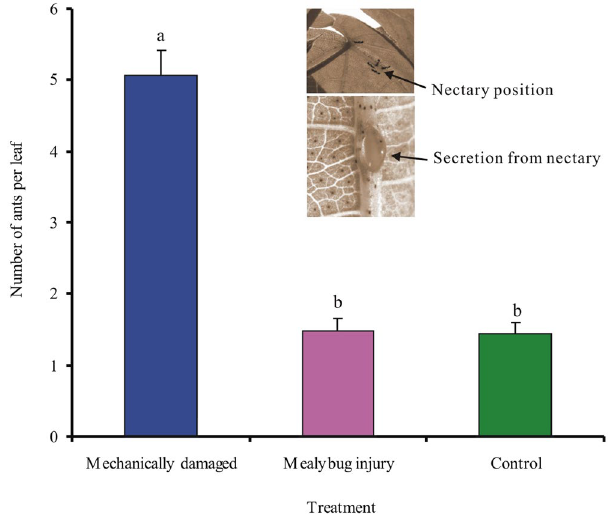
Figure 4. Numbers of ants near extrafloral nectaries located in the main veins on mechanically damaged, mealybug-infested, and control cotton leaves in experiment 3. The ants were counted 1 h after the experiment began. Each value is the mean ( + SE) of 10 replications.